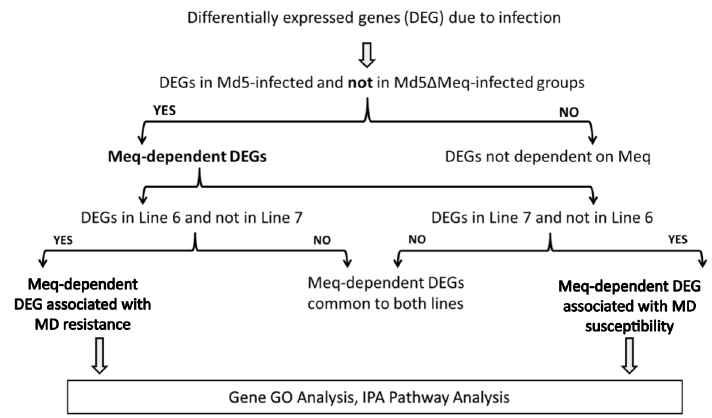
Figure 1. Schematic for analysis of experimental groups. The differentially expressed genes (DEGs) between Md5-infected and Md5 ∆ Meq-infected groups compared to untreated control CEFs were obtained. Then DEGs present in Md5-infected group and not in Md5 ∆ Meq-infected group were designated as Meq-dependent DEGs. These were further divided into DEGs specific to lines 6 or 7, and this set was used for GO categorization and IPA Pathway